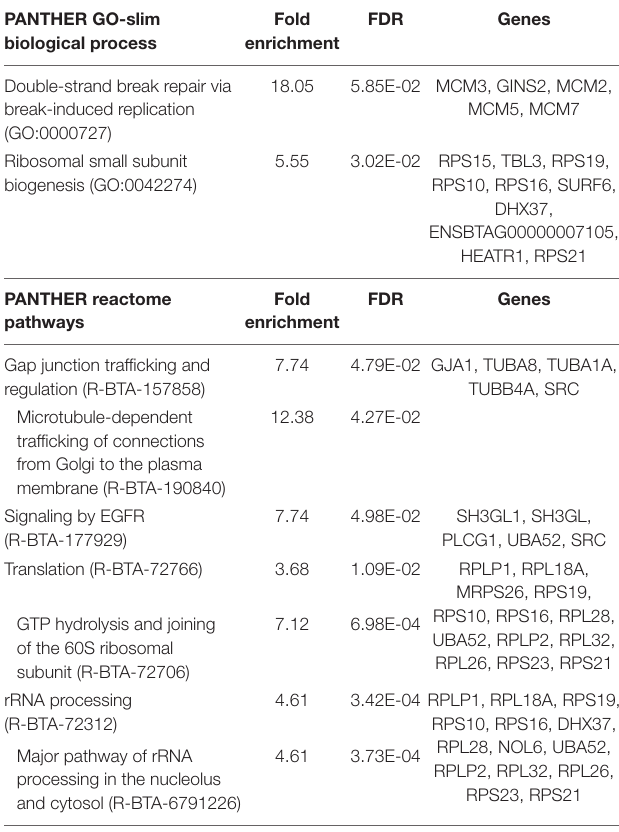
TABLE 3 | Enrichment of genes contributing to the first dimension of between-class PCA (positively correlated) and associated with ICM from the “SF” and “SF + PGE2” IVP treatment groups.